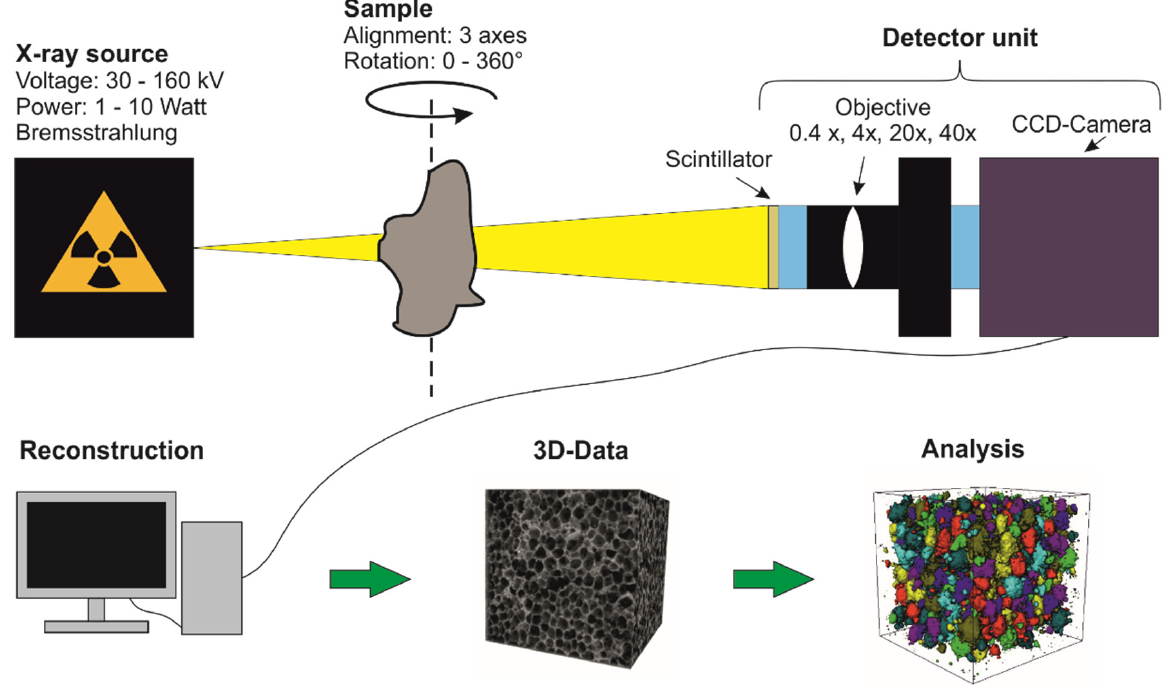
Figure 4. Schematic structure of a µ-CT measurement [22].